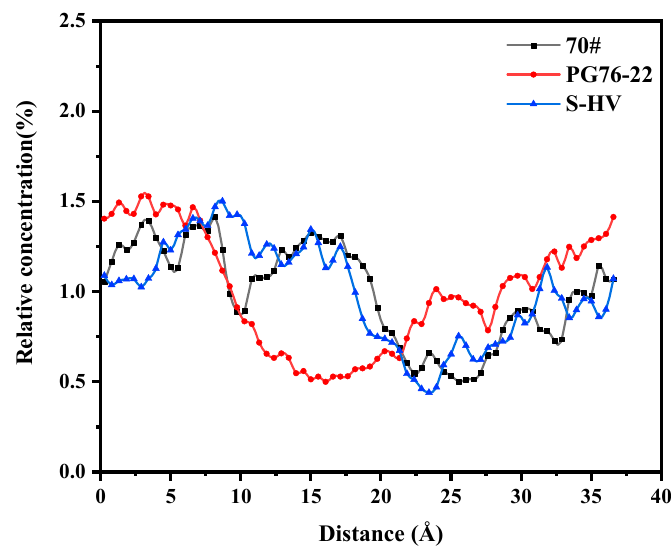
Figure 12. Solubility distribution of aromatics.